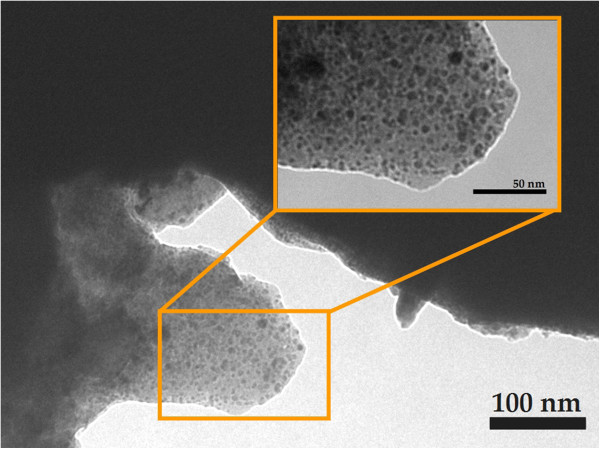
TEM photographs of a fragment of PMMA microcolumns in which (Er,Yb):Lu2O3 nanocrystals are embedded.